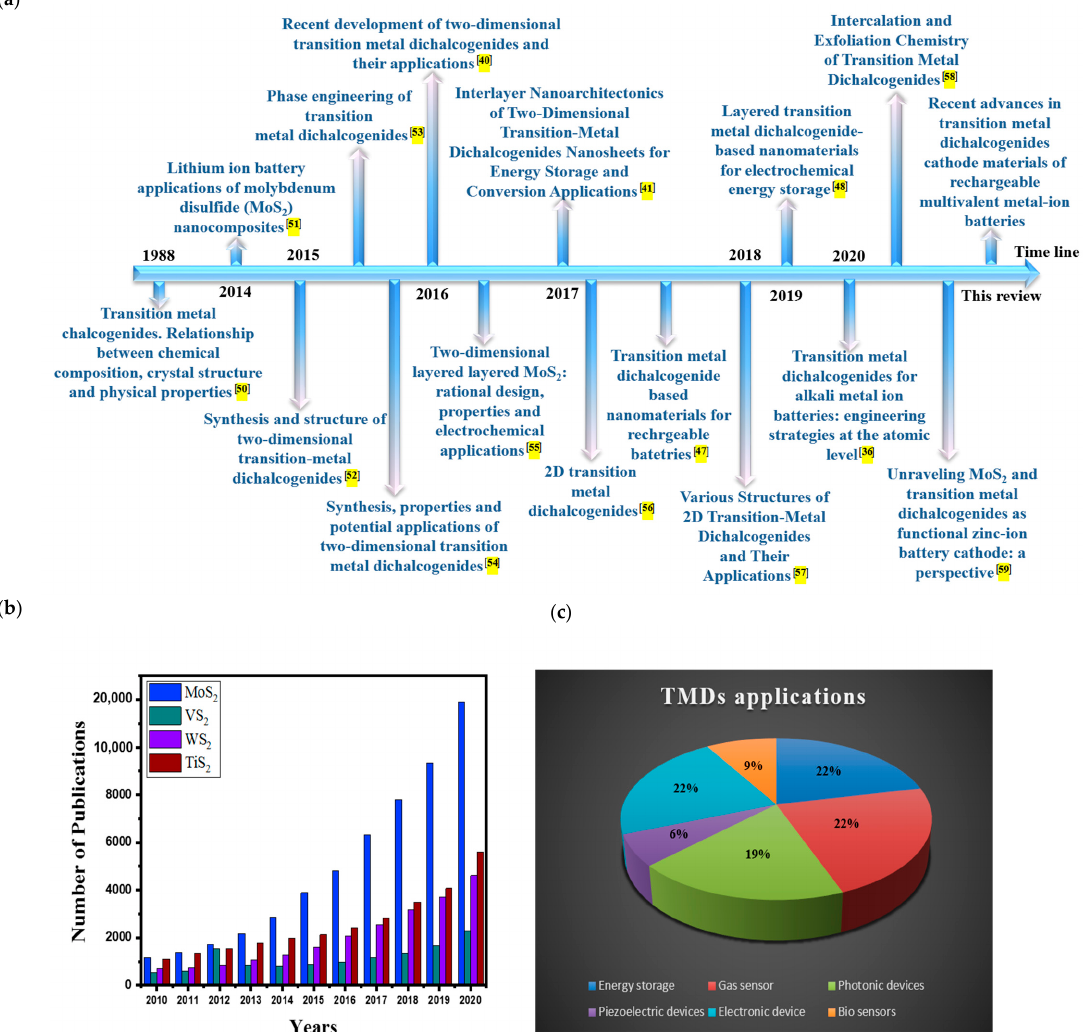
Figure 1. ( a ) Brief summary of recent reviews on transition metal dichalcogenides (TMD) materials, ( b ) Year-wise publication plot for TMD materials including MoS 2 , VS 2 , WS 2 , and TiS 2 in the period of 2010–2020. (searched by Google Scholar, 2 June 2021), ( c ) The applications of TMDs in the period of 2010–2020.